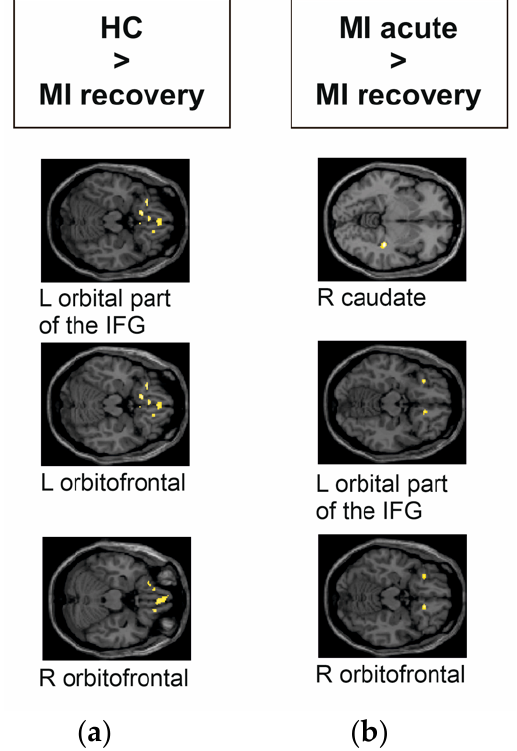
Figure 3. Group differences of myocardial infarction (MI) patients and HC during the emotional task-based fMRI paradigm during the decoding of aversive versus positive pictures from the IAPS. The images were presented in MNI space. MI acute phase compared to HC showed no significant differences. ( a ) MI recovery phase compared to HC had significantly lower responses in the left orbital part of the IFG, and in the left and right orbitofrontal regions. ( b ) MI acute phase compared to MI recovery phase had significantly higher activity in the right caudate, left orbital part of the IFG, and right orbitofrontal region. Table 3. Significant group differences between HC and MI while viewing aversive versus positive pictures during the emotional task-based fMRI paradigm.